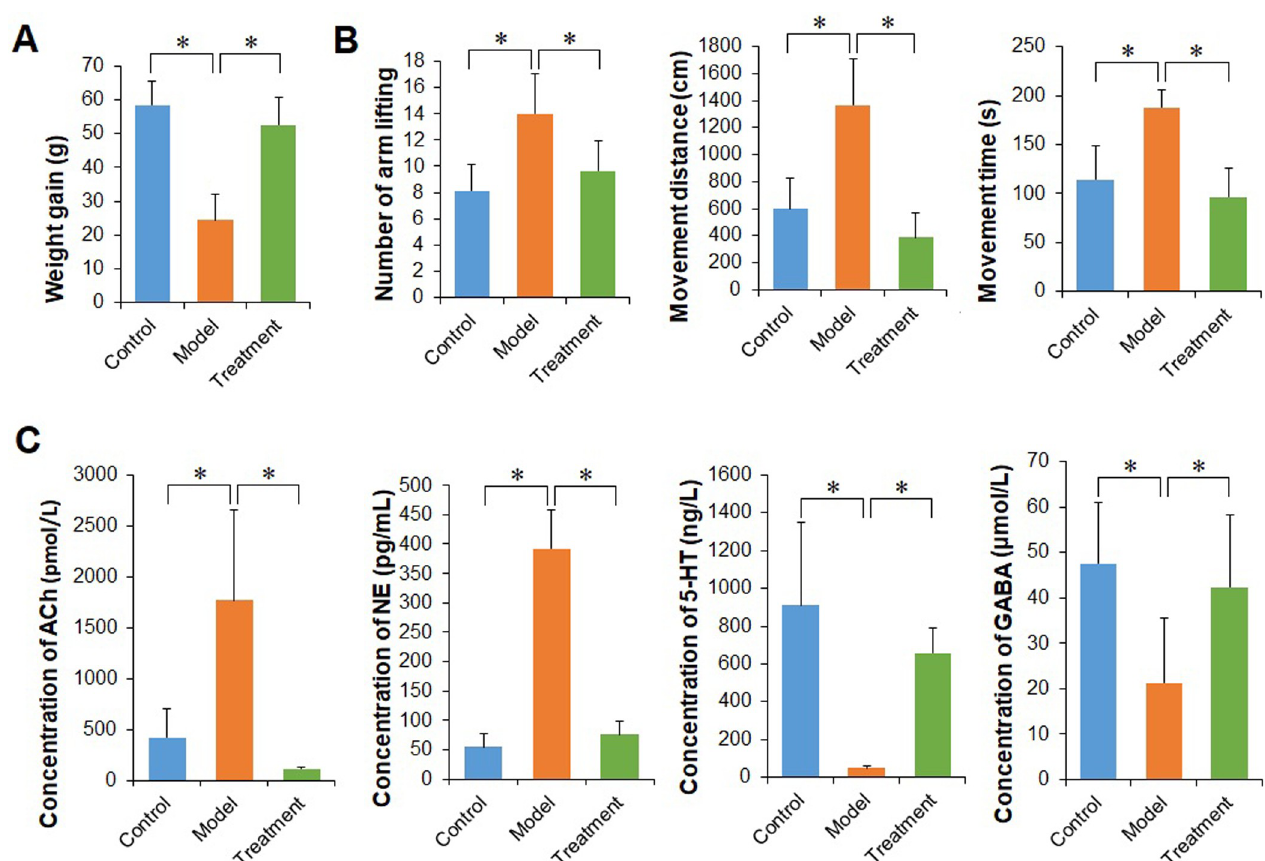
Fig 1. The therapeutic effect of the MMWA on insomnia rats. (A) Comparison of body weight gain of rats among three groups. (B) Comparison of the movement distance, movement time, and the number of arm lifting of rats among three groups. (C) Comparison of neurotransmitters in the serum of rats among three groups. Values are expressed as the means ± SD, n = 8 rats in each group ( � P < 0.05).